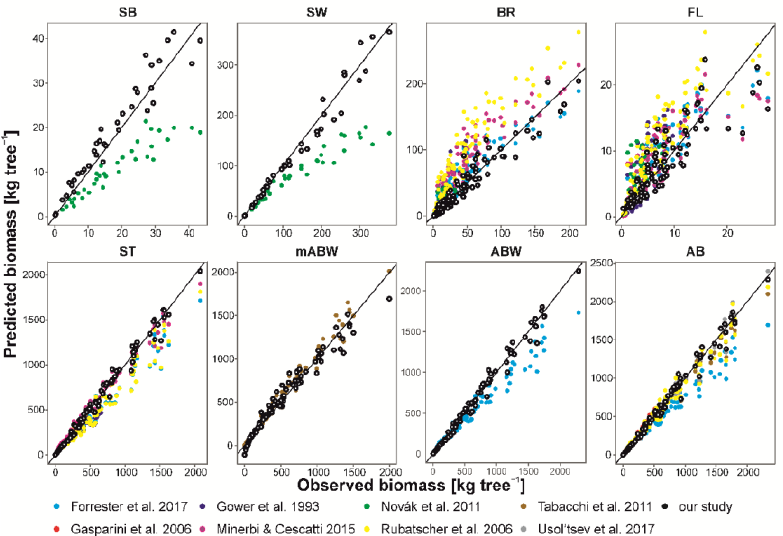
Figure 3. Biomasses calculated by our generalized (black dots) and published allometric equations, compared with observed biomasses. Line indicates 1:1 proportion. Biomass components: SB—stem bark biomass, SW—stem wood biomass, BR—branch biomass, FL—foliage biomass, ST—stem biomass, mABW—merchantable aboveground woody biomass, ABW—aboveground woody biomass, AB—total aboveground biomass. Note that we showed only trees from ± 20% of the diameter range of each model for comparison.